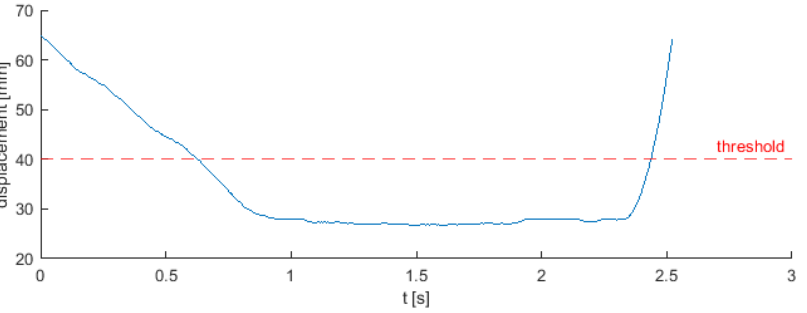
Figure 3. Example displacement signal from the entire process and 40 mm threshold.